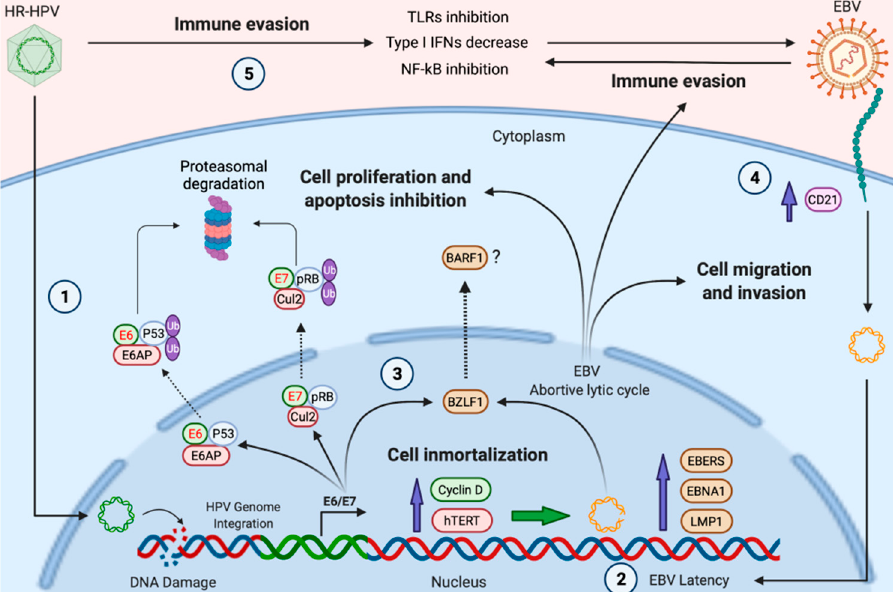
Figure 1. A hypothetical model of HPV and EBV cooperation for the development of HNCs. ( 1 ), HR-HPV infection and viral genome integration promote DNA damage in head and neck epithelial cells; ( 2 ), previous DNA alterations, as well as the increased expression of cyclin D1 and hTERT induced by HR-HPV, can promote the establishment of EBV latency; ( 3 ), HR-HPV E6/E7 oncoproteins induce the expression of BZLF1, favoring the expression of EBV lytic genes with oncogenic properties, such as BARF1 (abortive lytic cycle); ( 4 ), HR-HPV infection induces CD21 (CR2), which, in turn, facilitates EBV cell entry; ( 5 ), the expression of HR-HPV oncoproteins inhibits protagonists of the anti-viral immune response, inducing immune evasion. Green shapes with red text represent HR-HPV oncoproteins. Brown shapes symbolize EBV proteins. Created by BioRender.com (accessed on 5 November 2021).